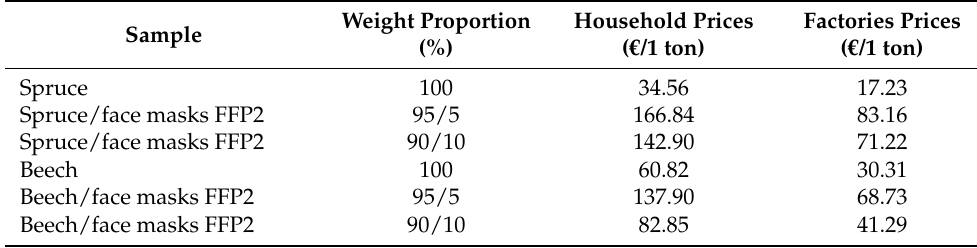
Table 2. Economic